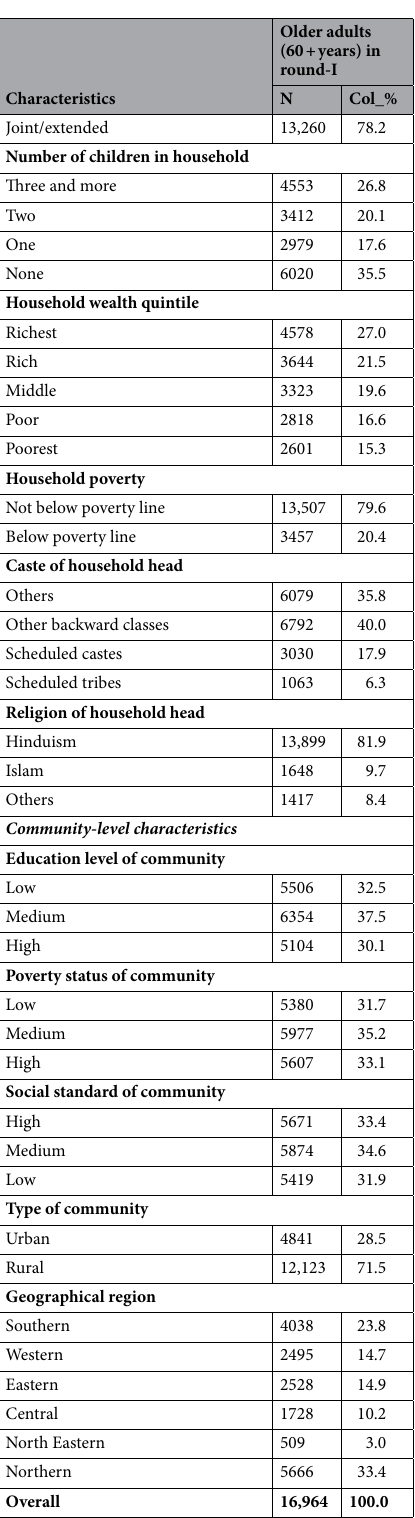
Table 1. Absolute (N) and percentage (%) distribution of older adults in India by individual-level, household- level and community-level characteristics during 2005. N, sample; Col_%, column